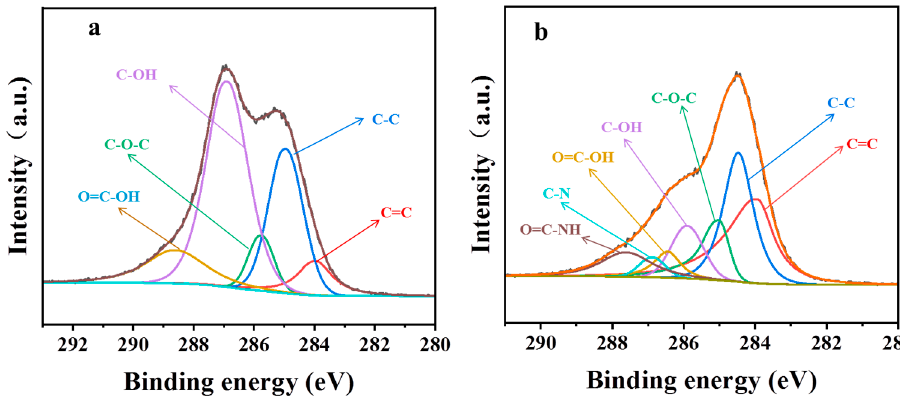
Figure 4. C1s spectrum of ( a ) GO and ( b ) PGO.